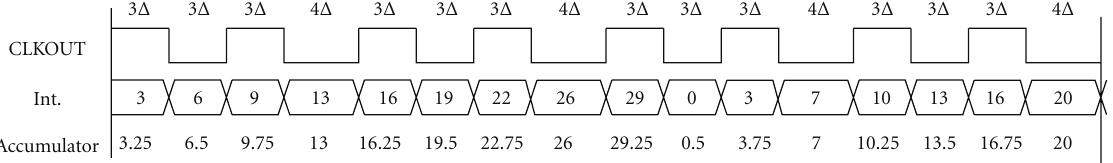
Figure 2: Numerical operation of [8]’s flying